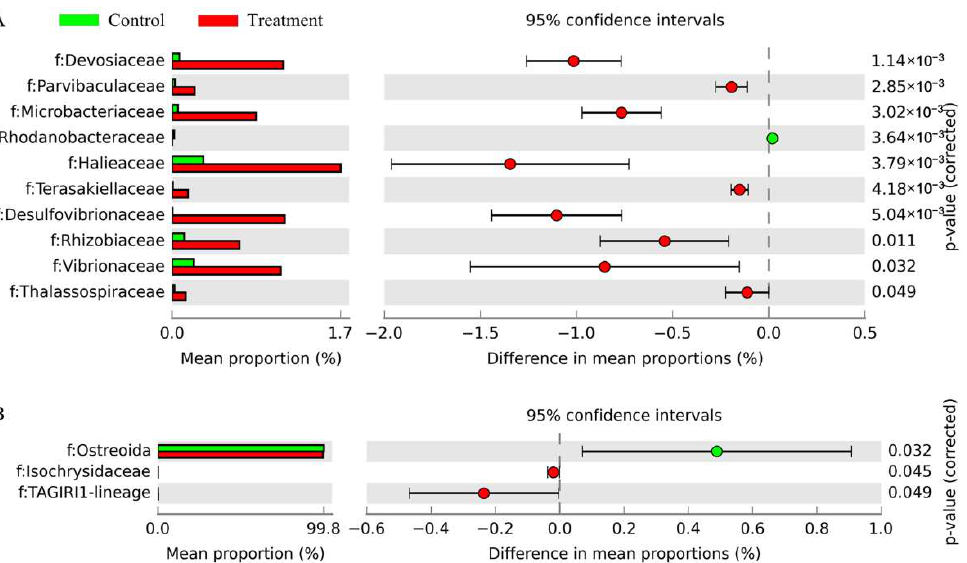
Figure 3. STAMP analysis identifying the significant differences of relative abundances of dominant taxa of the prokaryotes ( A ) and eukaryotes ( B ) at the family level in the control (green) and treatment (red) groups (95% confidence intervals) by using extended error bar plot. Corrected p- values are shown on the right. f represents the taxon at the family level.